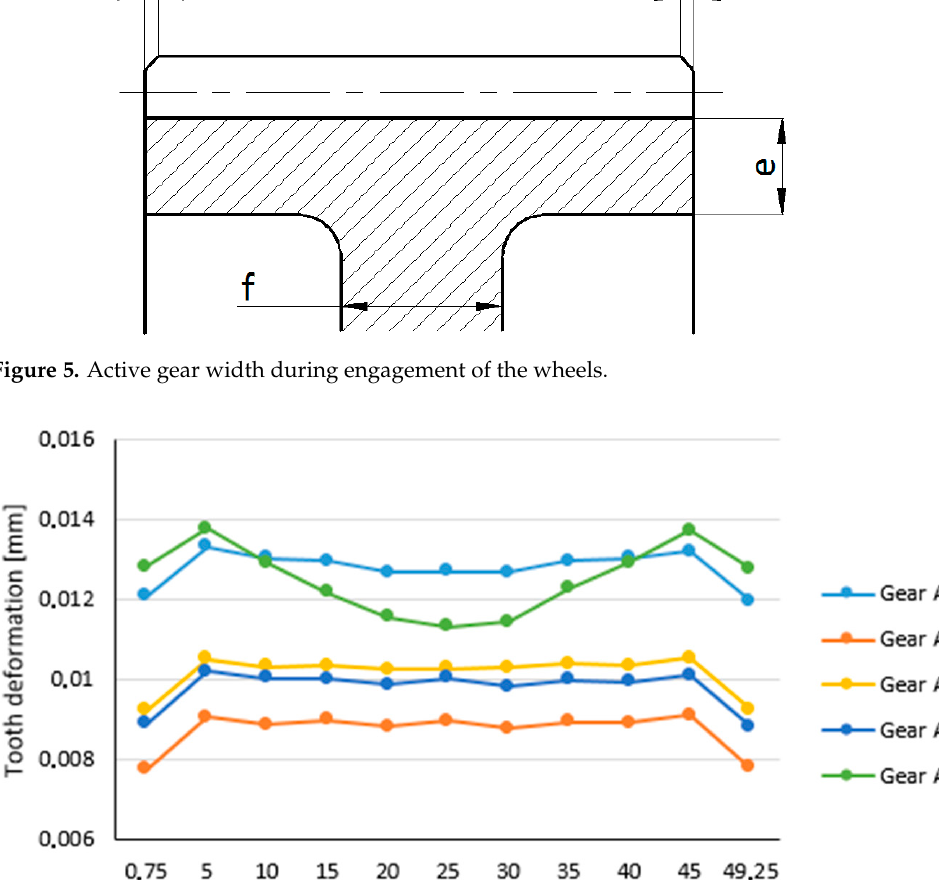
Figure 6. Comparison of tooth deformation along the width of the forged gear wheel for individual models. The deformation distribution along the width of the gear is also applied in Table 6.